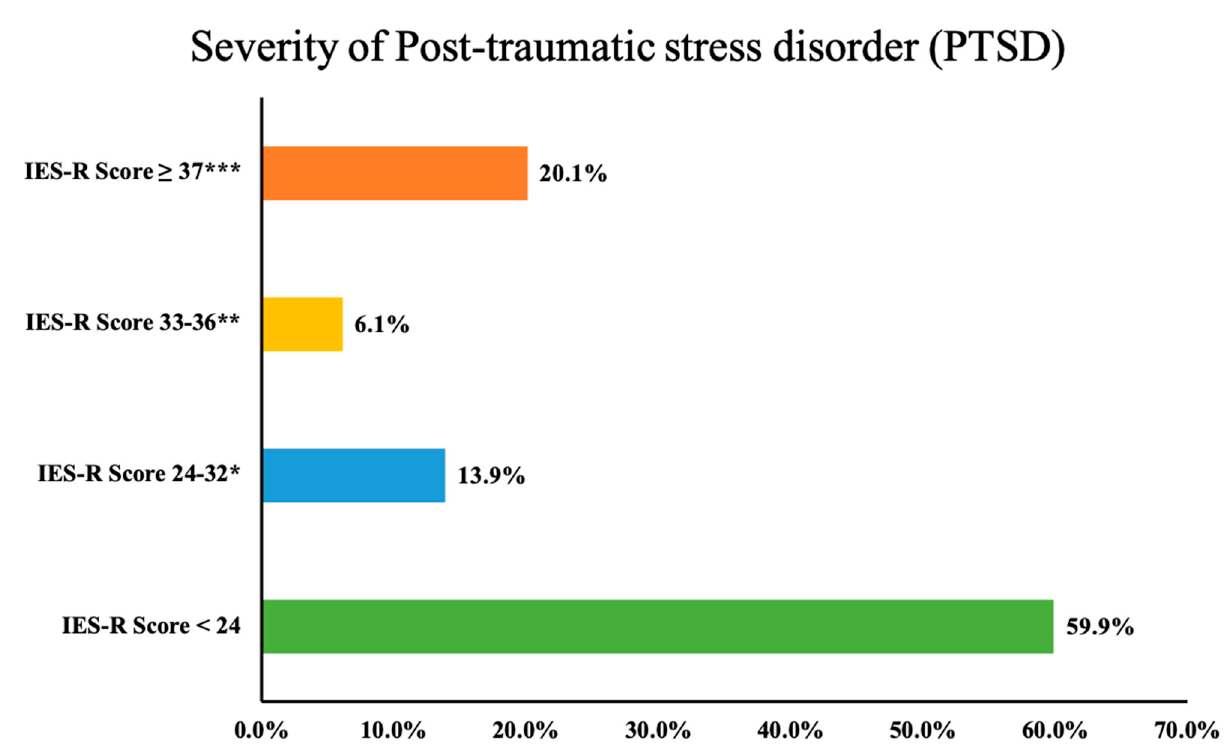
Figure 2. Severity of PTSD among the study participants (* Those with scores this high who do not have full PTSD will have partial PTSD or at least some of the symptoms. ** The best cutoff for a probable diagnosis of PTSD. *** It is high enough to suppress the immune system’s functioning (even 10 years after an impact event).